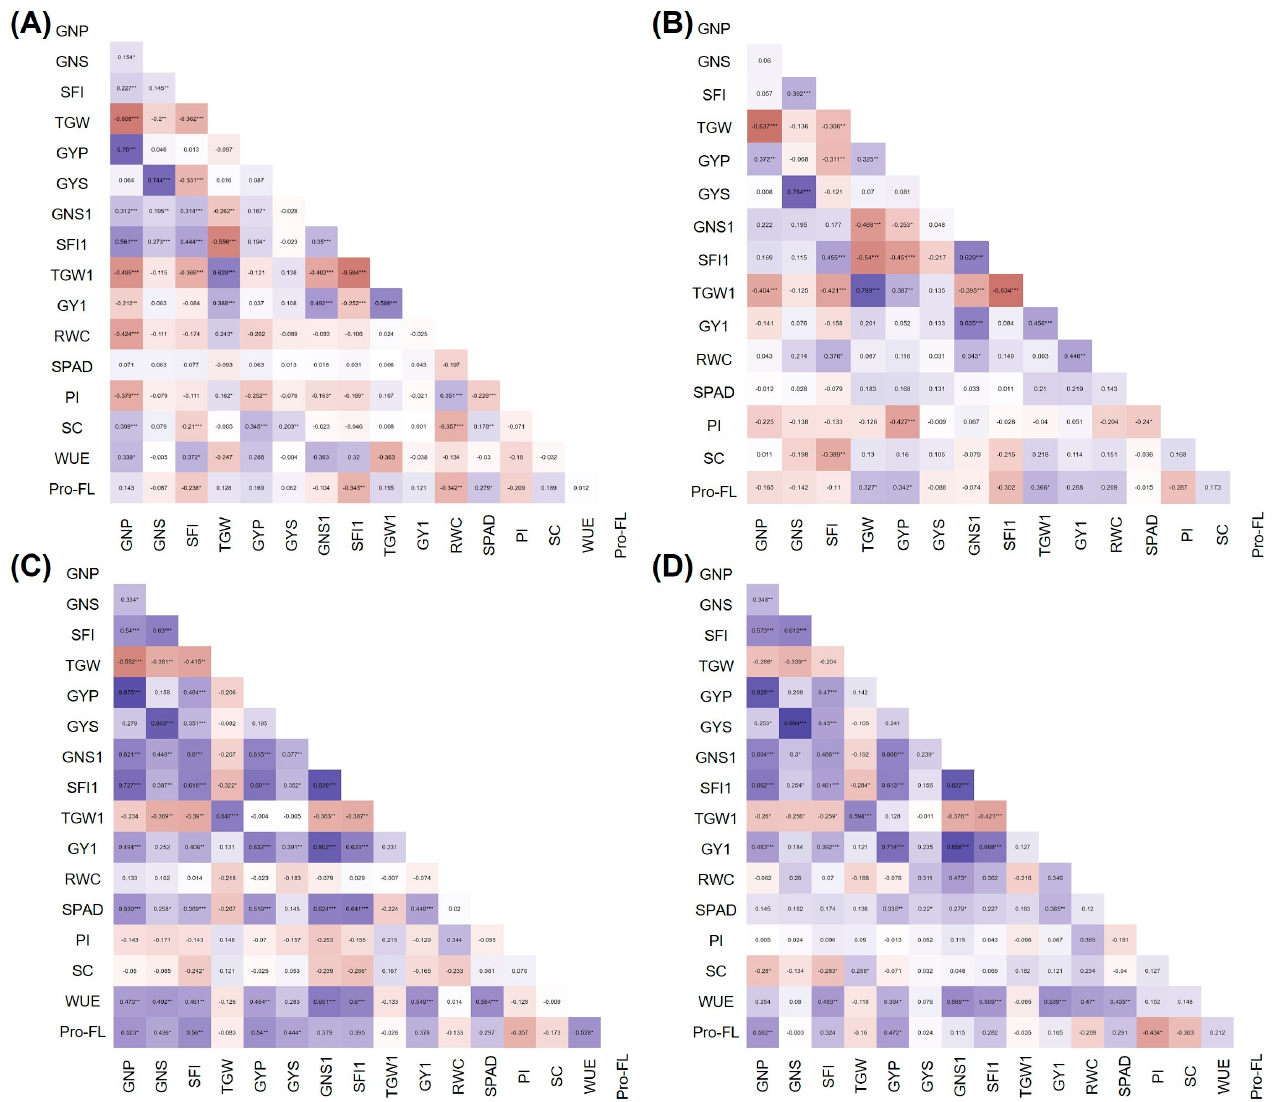
Figure 7. Heatmaps of Pearson’s correlation coefficients (r) between pairs of yield-related traits and physiological parameters under ( A ) control condition, ( B ) 3-day heat stress, ( C ) combined water and 3-day heat stress (WH3); and ( D ) combined water and 7-day heat stress (WH7). Violet and brown colours correspond to positive and negative correlation, respectively. The saturation of colours reflects the absolute value of r. *, ** and *** indicate p < 0.05, p < 0.01, and p < 0.001 significance levels, respectively. For trait acronyms, see the Materials and Methods section.